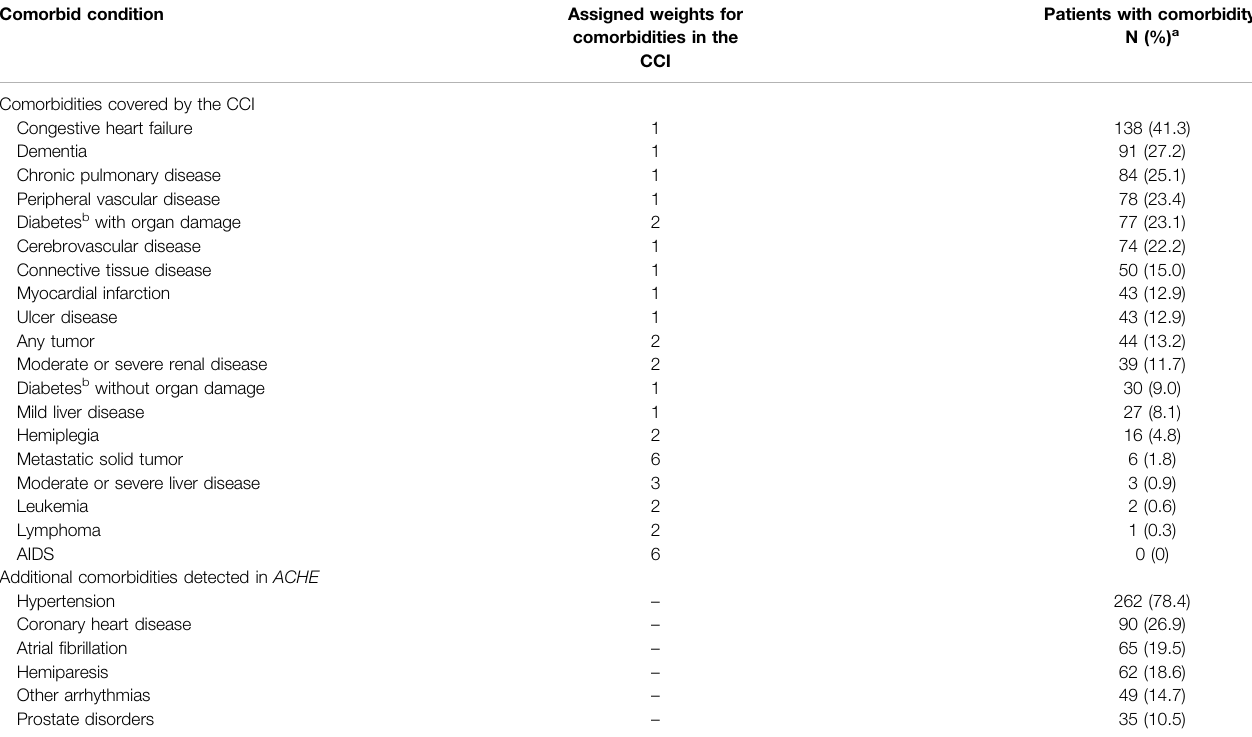
TABLE 2 | Prevalence of comorbidities among elderly receiving home care ( N (cid:1) 334). Comorbid condition